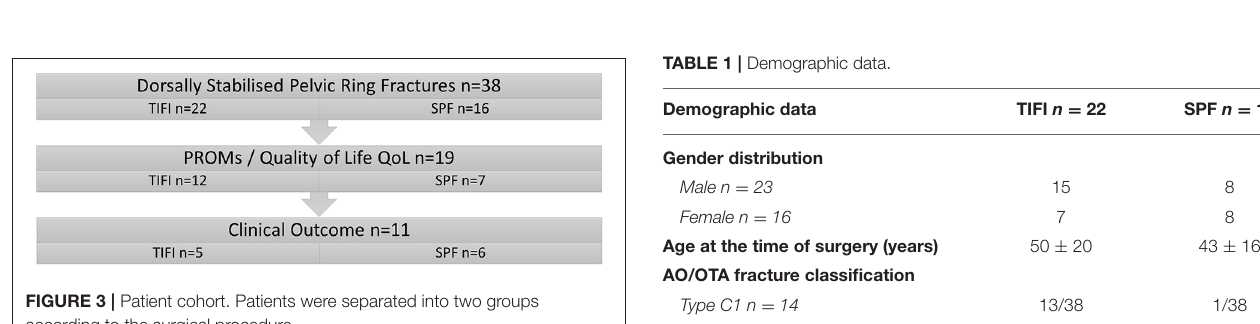
FIGURE 2 | SPF. Female patient (29 years old) with spinopelvic dissociation and bilateral sacral fracture after road accident. The injury was classified ( a: CT scan coronal, b: transversal) as AO C3.3. Surgery was performed with spinopelvic fixation (SPF) (L5 to Os ilium) (c) .